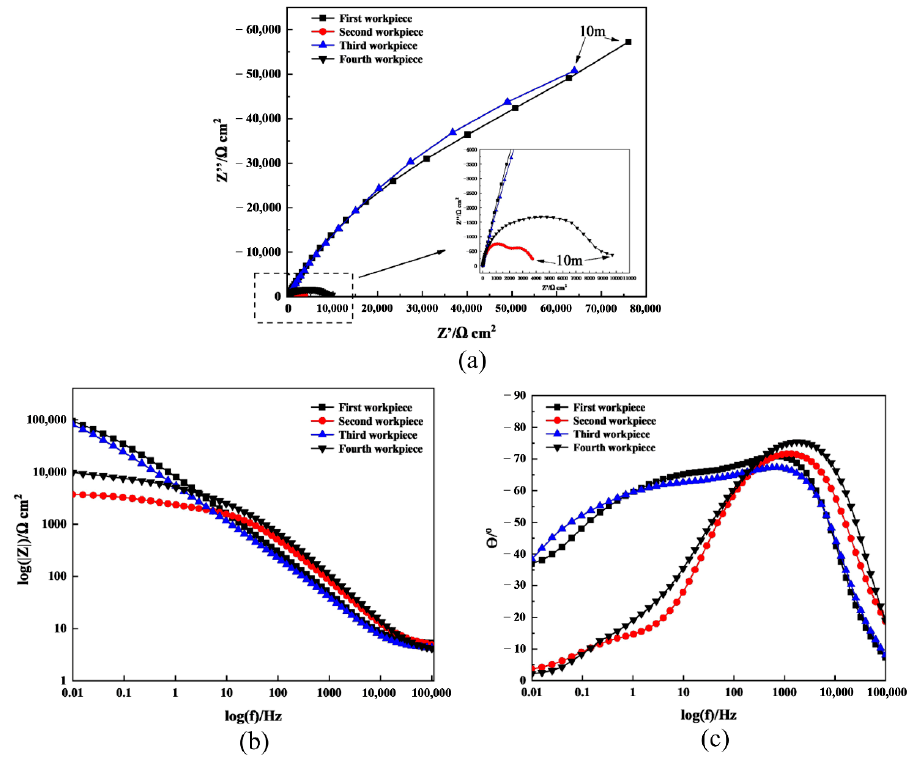
Figure 8. EIS curves for different pretreatment modes. ( a ) Nyquist plots; ( b ) Bode impedance plots; ( c ) Bode phase plots. ( c ) Bode phase plots. Table 6. EEC model fitting parameters of TC4 samples subjected to different pretreatments. Table 6. EEC model fitting parameters of TC4 samples subjected to different